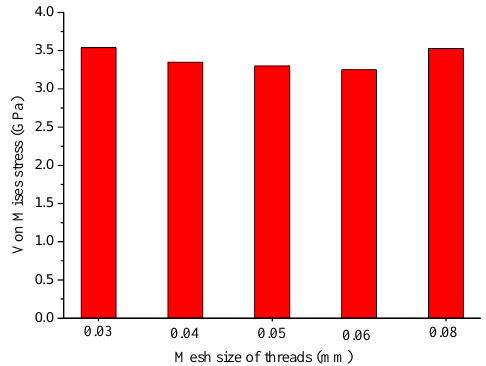
Figure 6. The Von Mises stress as a function of mesh size.